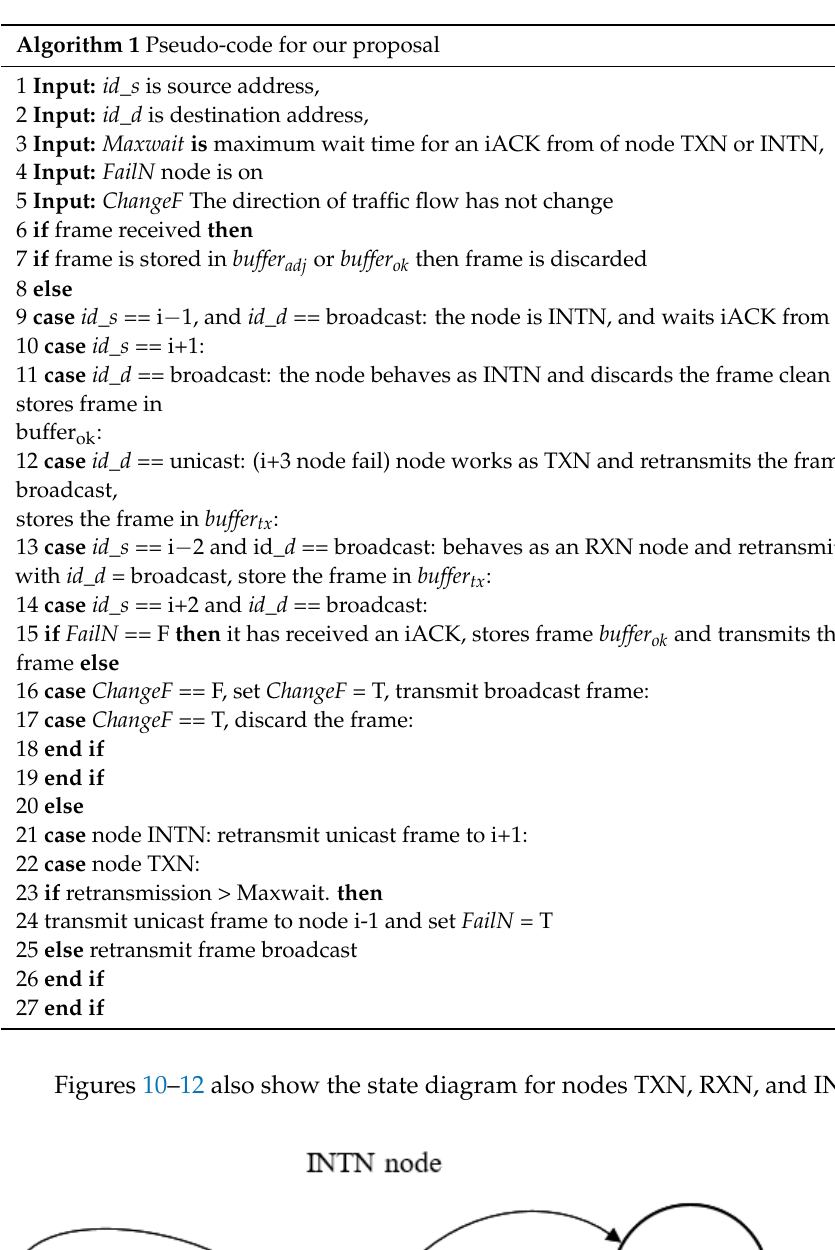
Algorithm 1 Pseudo-code for our proposal